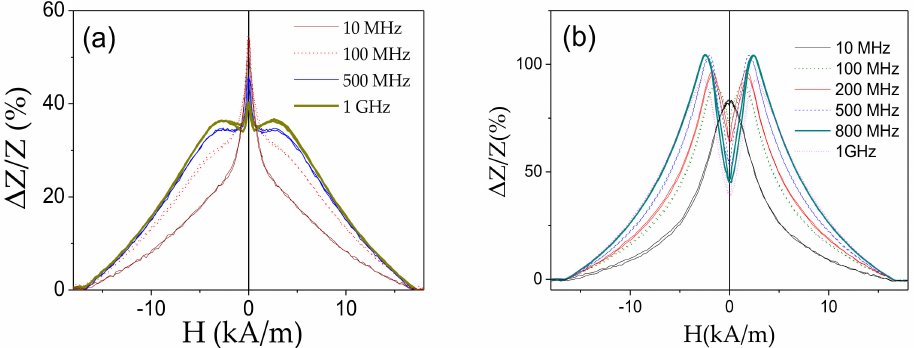
Figure 13. ∆ Z / Z(H) dependencies of as-prepared; and ( a ) annealed at 550 ◦ C (1 h) ( b ) Fe 71.7 B 13.4 Si 11 Nb 3 Ni 0.9 microwires measured at different frequencies. Figure 12a is adapted from ref. [62].